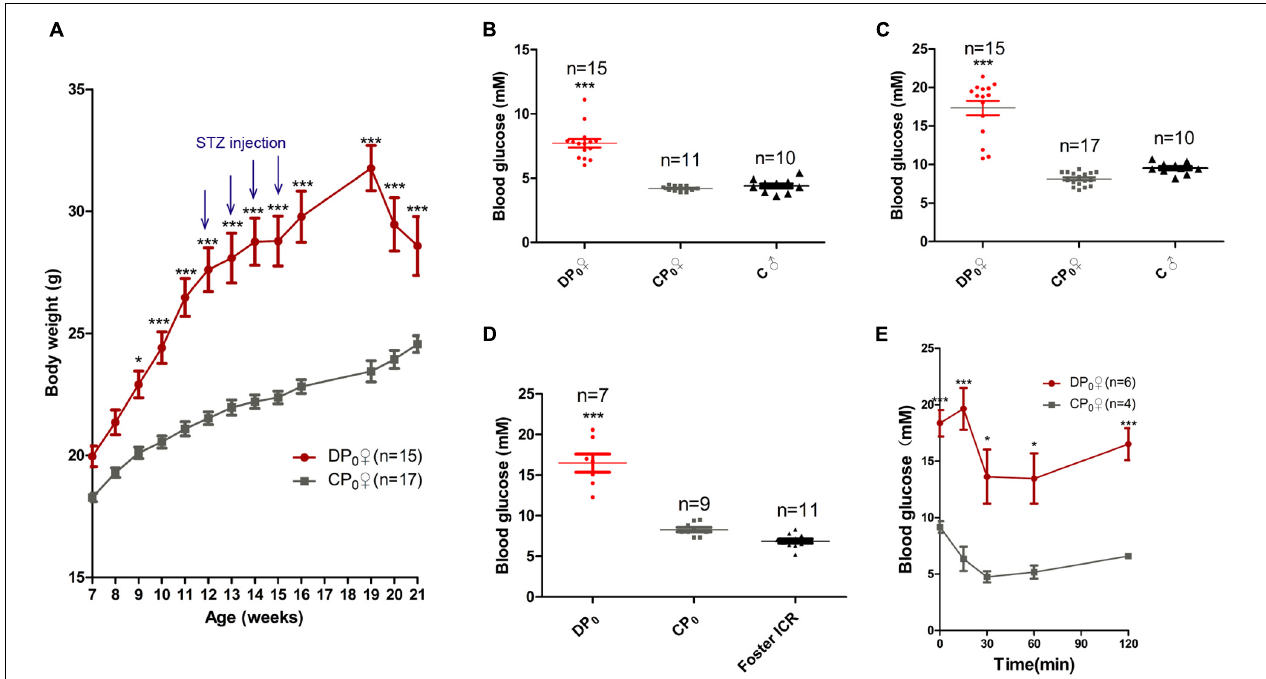
FIGURE 2 | Maternal (P 0 ) metabolic phenotype. (A) Body weight gain from 7 to 21 weeks. (B) Fasting plasma glucose. (C) Casual plasma glucose. (D) Gestational plasma glucose. (E) ITT at 21 weeks of age. Data are expressed as mean ± S.E.M.; * P < 0.05, *** P < 0.001 vs. CP 0 control. A two-way repeated measurement ANOVA in (A,E) and a one way ANOVA in (B–D) , post hoc Bonferroni multiple-comparisons test was used to assign P -values. P -values for significance between groups in repeated measure analysis are